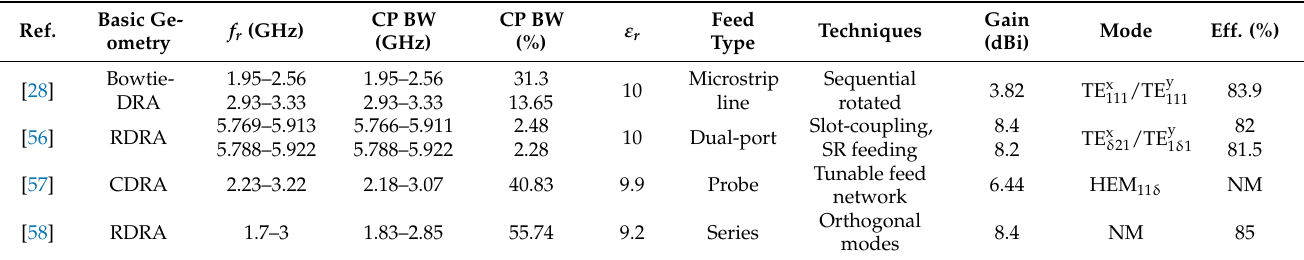
Figure 13. Proposed broadband dual CP DRA: ( a ) 3D view; ( b ) feeding network [58]. Table 3. Comparison between different dual- or multi-feed circularly polarized DRAs.